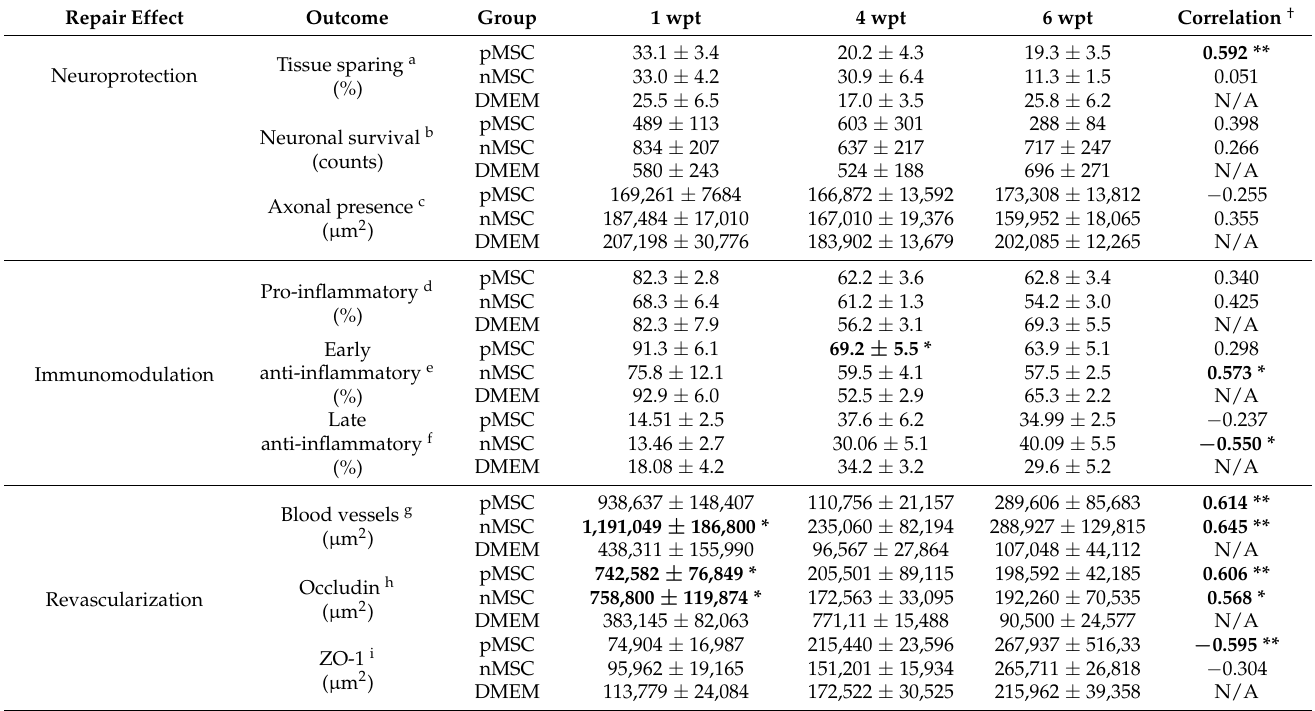
Table legend: Histological outcome values represent the mean and the standard error of the mean (SEM). a Percentage of tissue sparing in the contused spinal cord in reference to an equally sized segment of a healthy cord; b sum of neuronal bodies rostral and caudal to the injury cavity; c area of neurofilament positive staining representing axonal presence in the contused spinal cord; d percentage of macrophages positively stained for CD86 in the injury site; e percentage of macrophages positively stained for CD206 in the injury site; f percentage of macrophages positively stained for CD163 in the injury site; g area of RECA-1 positive staining in the injury site; h Area of occludin-positive staining in the injury site; i Area of ZO-1 positive staining in the injury site. (*) One asterisk indicates statistical significance when p ≤ 0.05, (**) and two asterisks indicate statistical significance when p ≤ 0.01. (†) The right-most column presents the Pearson correlation coefficient from evaluating the correlation between the histological outcome on each row and the amount of transplant present in the injury site.